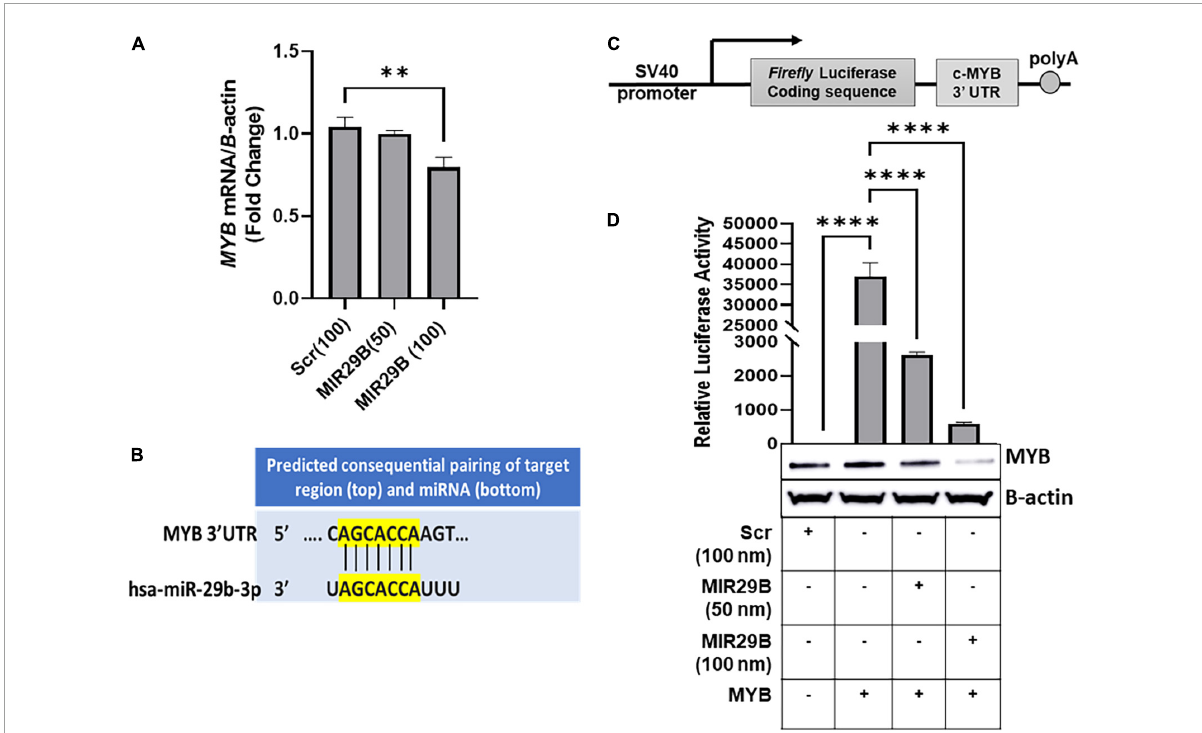
FIGURE1 MicroRNA29B (MIR29B) targets 3 (cid:48) -untranslated region (UTR) of MYB in KU812 cells. (A) Real-time PCR analysis of MYB mRNA relative to β -actin internal control in KU812 cells transfected with MIR29B mimic (50 and 100 nM) or scrambled (Scr) control (100 nm). (B) Complementary sequence for MIR29B and the 3 – UTR of MYB. (C) Luciferase reporter construct containing the c- MYB 3 (cid:48) -UTR. (D) Luciferase activity in KU812 cells 48 h after transfection with MIR29B mimic (50 and 100 nM) and MYB 3 (cid:48) -UTR reporter plasmid. Accompanied Western blot showing expression of MYB protein in cells co-transfected with MYB overexpression plasmid and MIR29B mimic or Scr control (100 nm). The + and – signs indicate the presence or absence of MYB or MIR29B overexpression in KU812 cells. Data are shown at the mean ± standard error of the mean (SEM). **P < 0.005, *** P < 0.0005, and **** P < 0.0001 is statistically